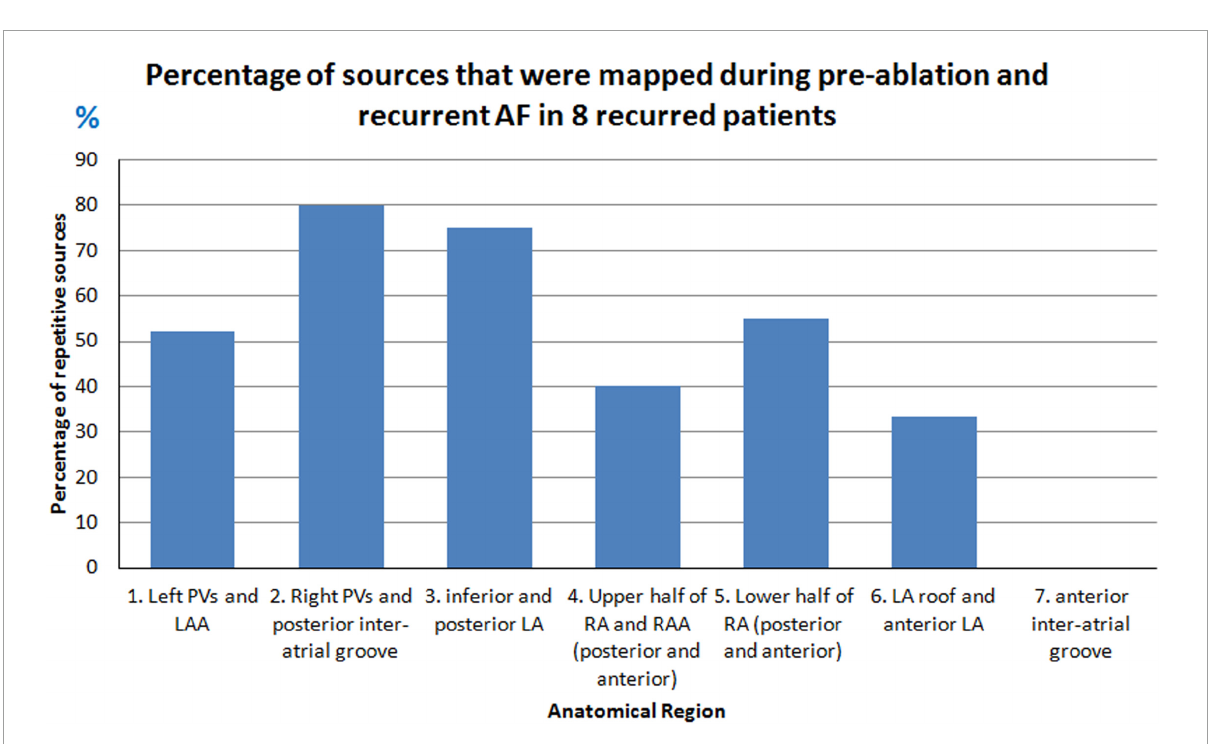
Figure 11 shows an example of a source that was mapped during pre-ablation AF and persisted during recurrence. A 65- year-old male with 12 months of persistent atrial fibrillation was mapped before his first ablation. Panel A shows a pre- ablation AF driver from the right superior pulmonary vein (RSPV; white asterisk) mapped twice ( t = 0, t = 264) within the same mapping interval. A wavefront originates from the RSPV and branches at the posterior septal roof ( t = 3; t = 5). Both branches propagate along the roof toward the LA free